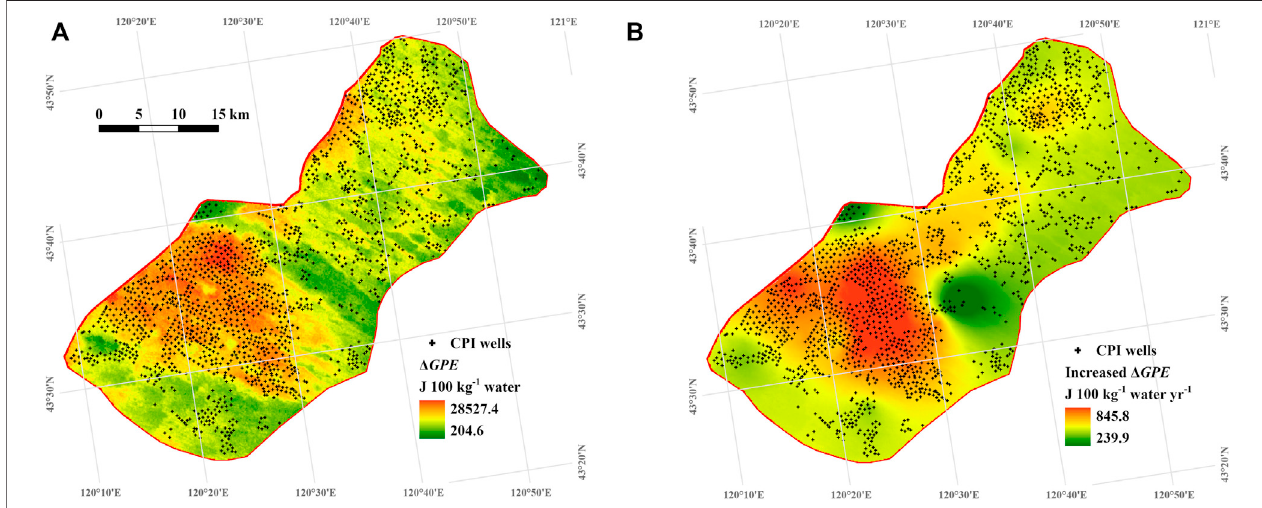
FIGURE 6 | Change in gravitational potential energy ( Δ GPE ) during 2019 – 2021. (A) Spatial pattern of Δ GPE from the average groundwater level in October to ground. (B) Increased Δ GPE based on averaged Δ GL (the change of the groundwater level). CPI, center-pivot irrigation.